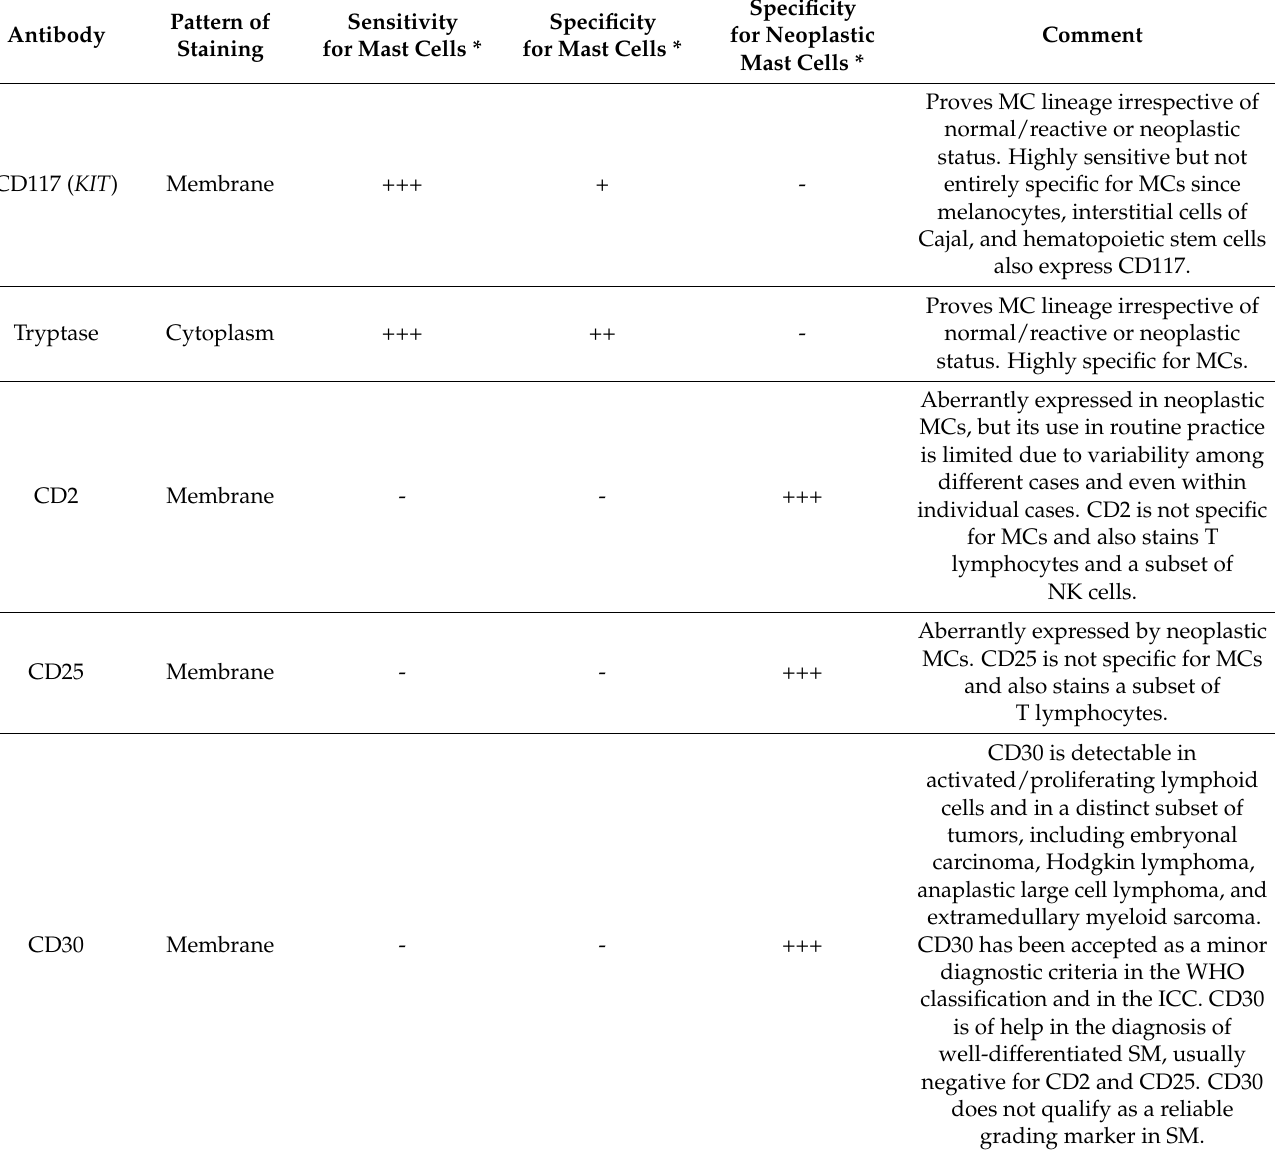
Table 1. Immunohistochemical markers employed in the diagnosis of SM. Of note, CD2, CD25,